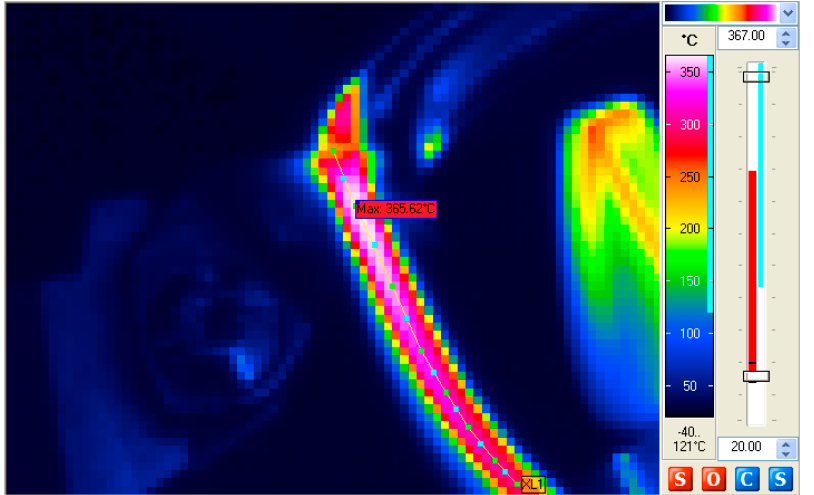
Figure 5. A thermogram of the cutting zone recorded for the insert coated with AlTiN at a cutting speed of v c = 100 m/min and feed of f = 0.20 mm/rev.